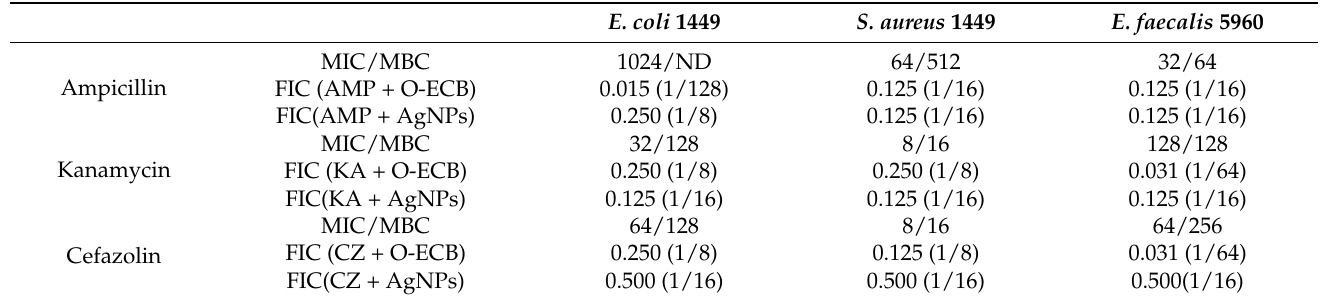
Table 8. Synergy of ampicillin, kanamycin, and cefazolin with O-ECB and AgNPs. E. coli